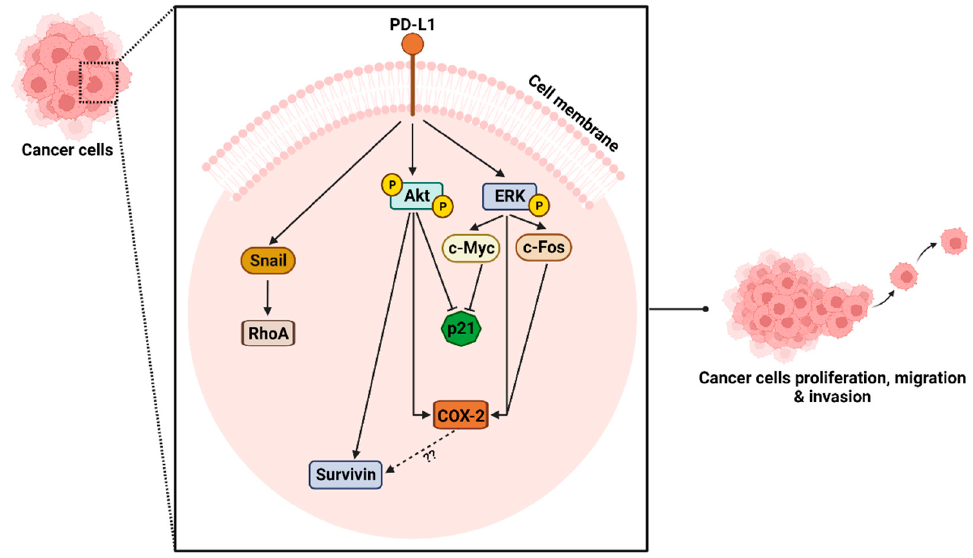
Figure 10. Diagram highlighting the potential downstream signaling of PD-L1 in TNBC. Created with BioRender.com.